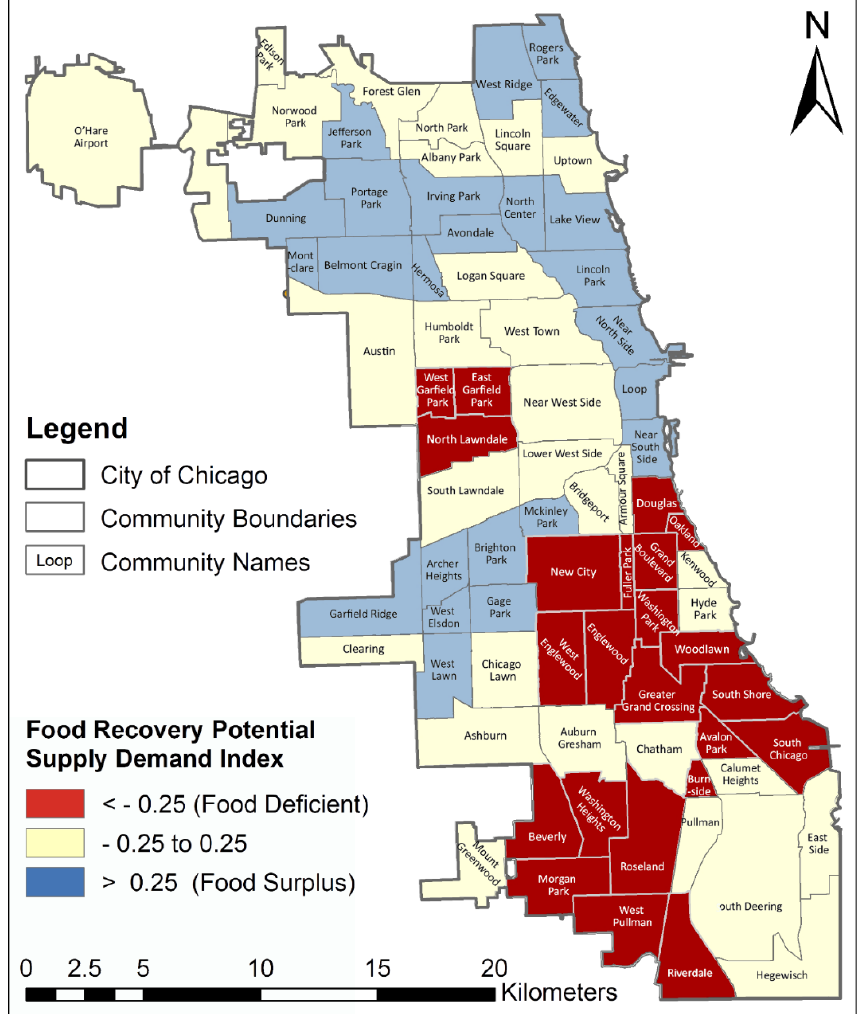
Figure 4. Spatial Matching of Food Waste Donation Potential and Food Banks by Chicago Community